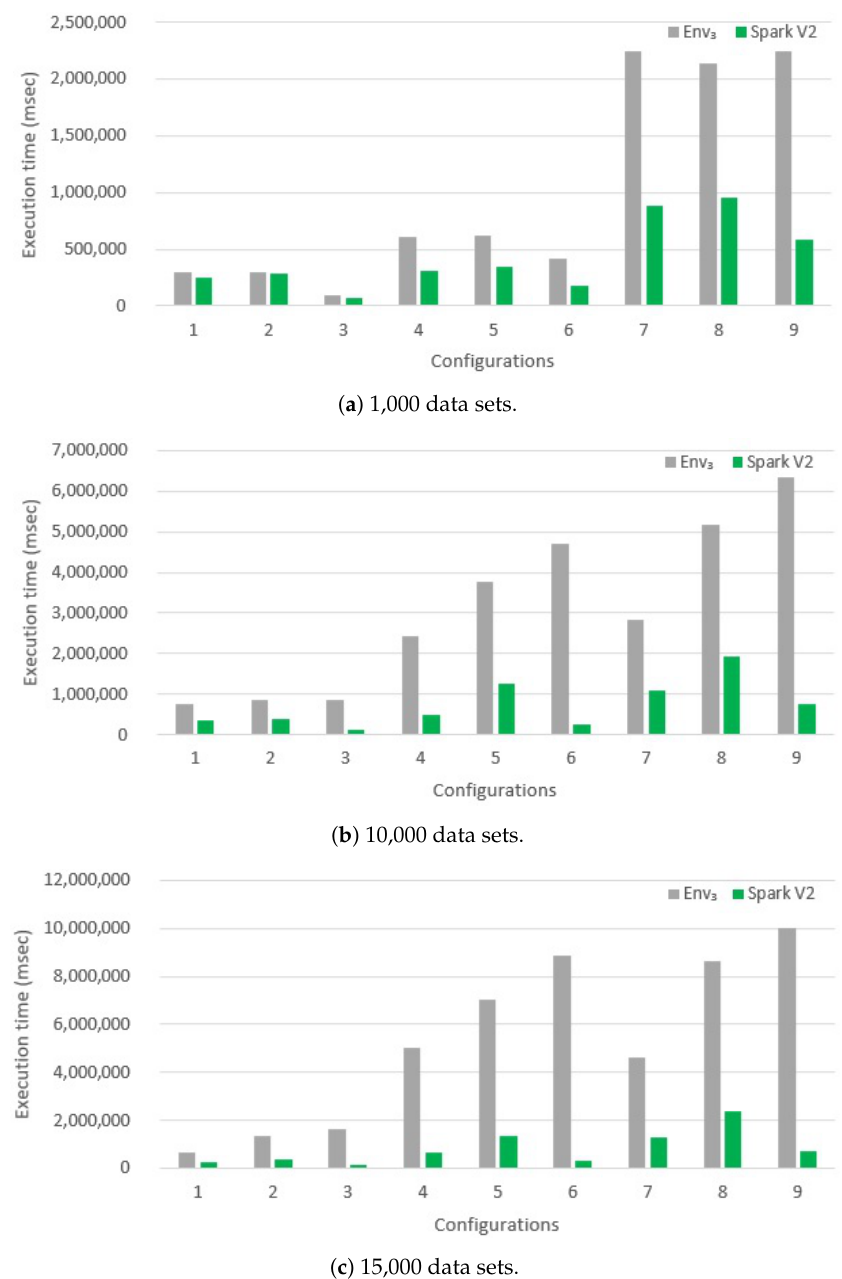
Figure 9. Comparing execution times of Step 4 for each configuration, between the basic Spark version ( Env 3 ) and the enhanced Spark version ( Spark V2